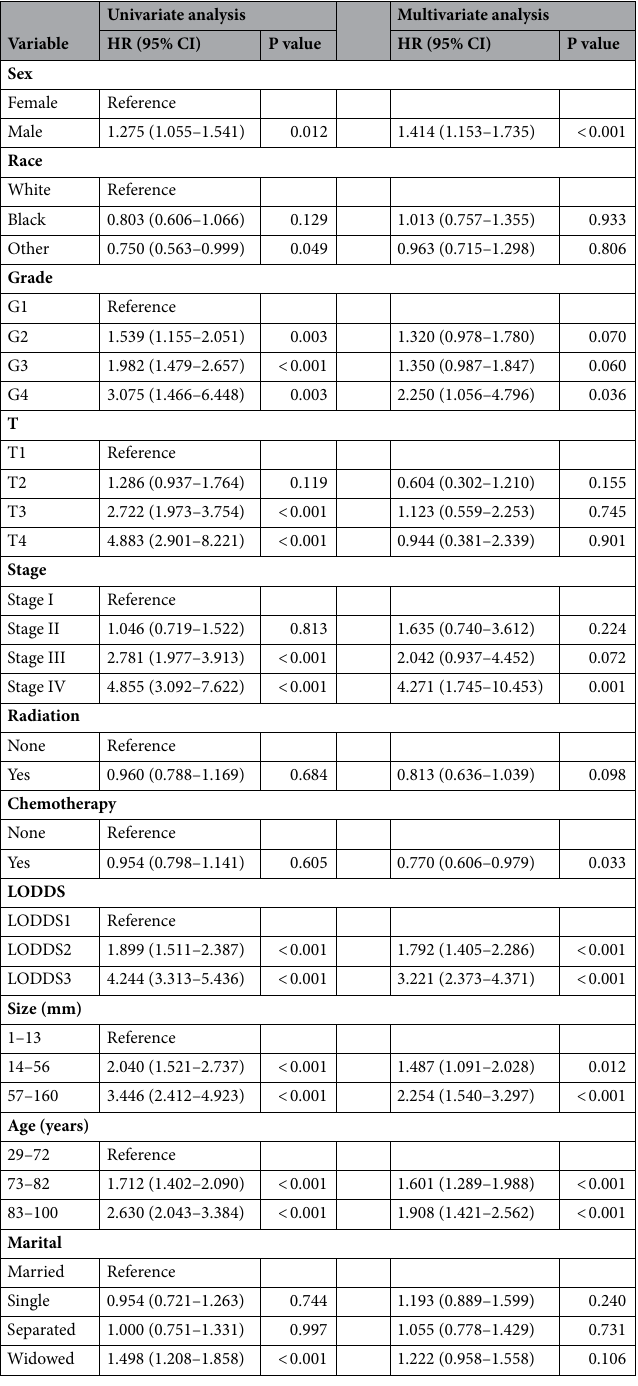
Table 2. Univariate and multivariate Cox analyses on variables for the prediction of overall survival of NM-GBA patients. HR hazard ratio, CI confidence interval, LODDS log odds of positive lymph